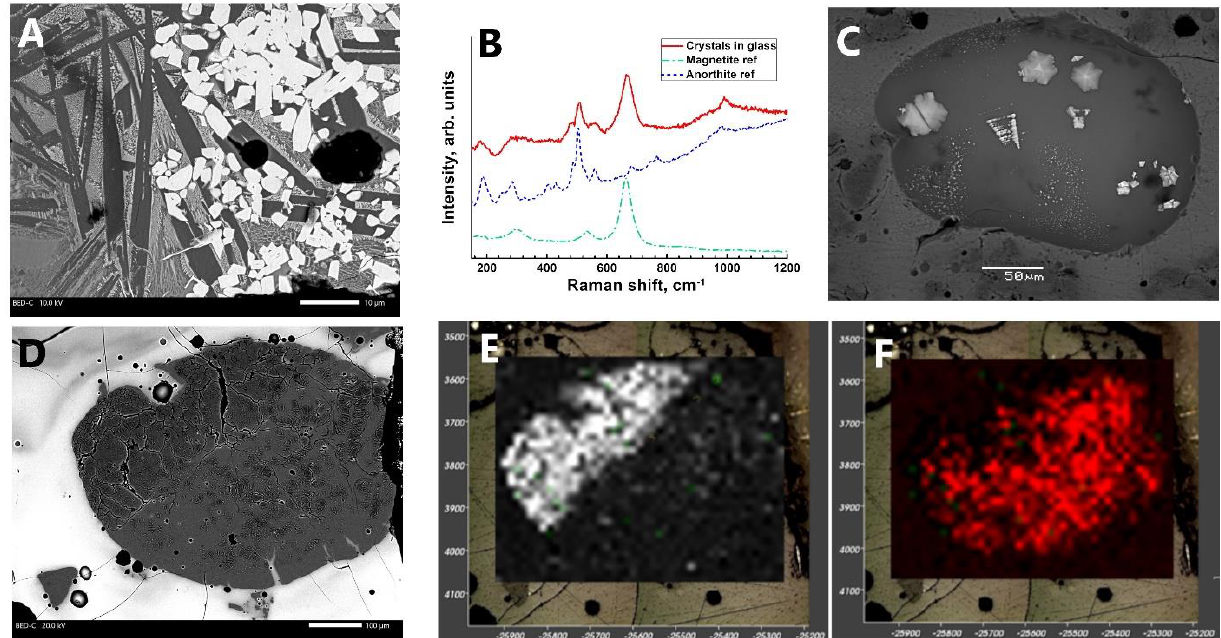
Figure 8. Peculiar mineral forms in the ground glass sample HK-2. ( A , B ) SEM image and Raman spectra of anorthite and Ti-magnetite; reference spectra are from [44]. ( C ) A bubble with Fe-oxide crystals decoration internal walls. ( D – F ) A quartz grain made of two SiO 2 polymorphs. ( D ) SEM-BSE image; ( E ) Raman map of cristobalite (mapped intensity in the 388 – 435 cm −1 range); ( F ) Raman map of quartz (mapped range 442 – 476 cm −1 ).